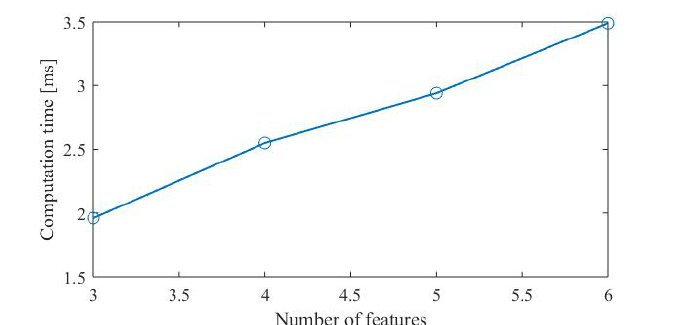
Figure 11. The relationship between the calculation time and the number of